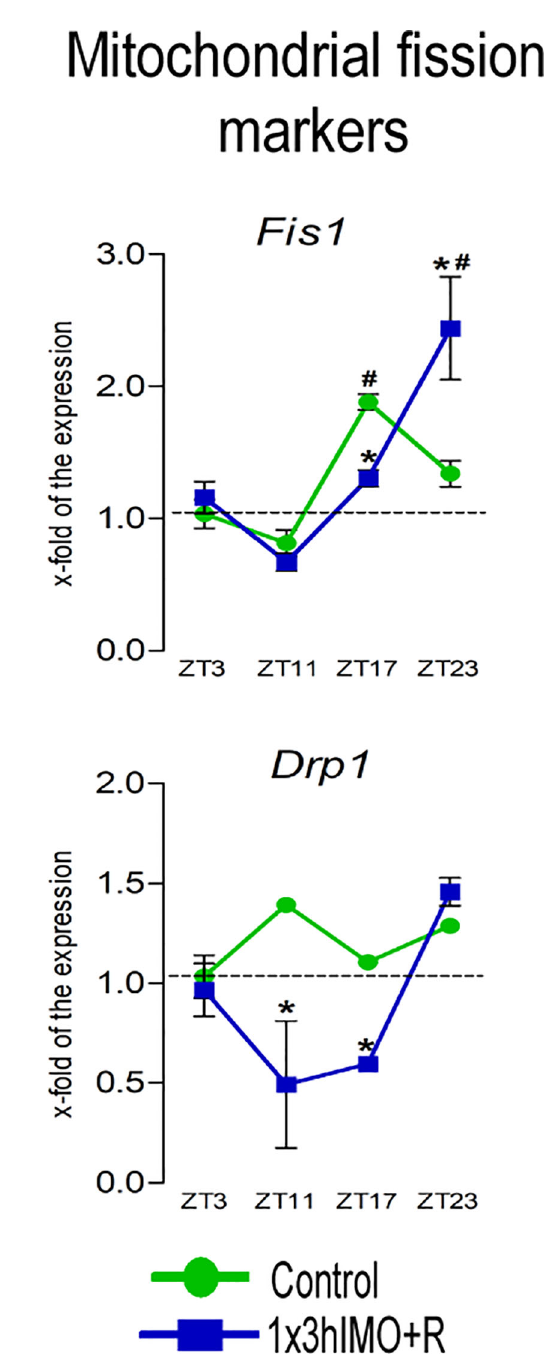
FIGURE 6 | Transcription of mitochondrial autophagy markers is signi fi cantly changed in spermatozoa of acutely stressed adult rats in a time-dependent manner. Isolated RNA from spermatozoa of undisturbed and stressed rats was used for the analysis of the transcriptional pro fi le of markers of mitochondrial autophagy. Data are presented as green dots connected with a green line for the control group, and blue squares connected with a blue line for the 1x3hIMO group, and are mean ± SEM values of two independent in vivo experiments. Statistical signi fi cance was set at p < 0.05: * vs. the control group of the same time point, # vs. the control group of ZT3 time